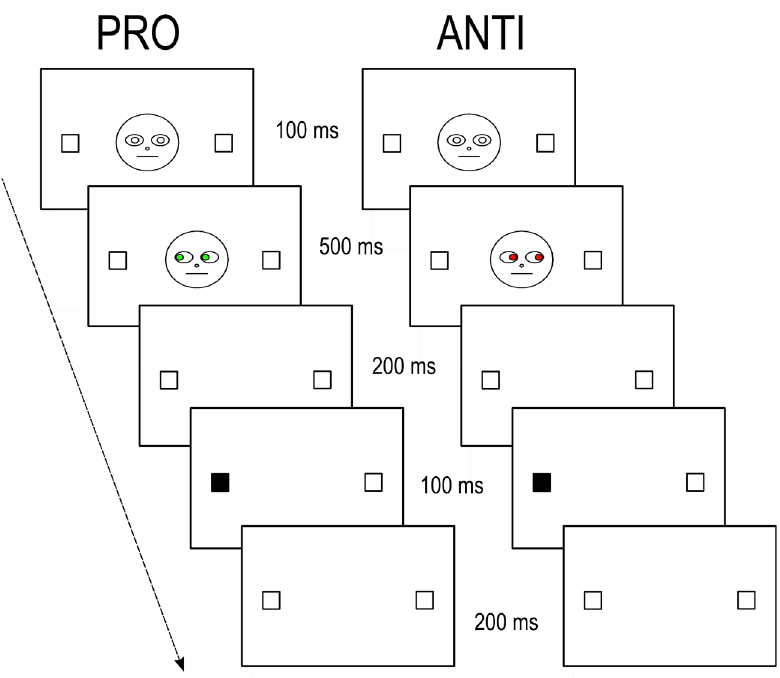
Fig 2. Trials examples of the modified version of the anti-saccade task. A typical trial of the modifiedanti- saccade task. We present PRO and ANTI trials for the changed-gaze condition. One trial (in the PRO condition) includeda gaze directionon the same side as the displayside of the target (congruentcondition), in which participants were instructed to press the keyboardon the same side of the target. The other trial (in ANTI condition) includeda gaze direction on the oppositeside of the displayside of the target (incongruent condition) in which participantswere instructed to press the keyboard on the opposite side of the target.